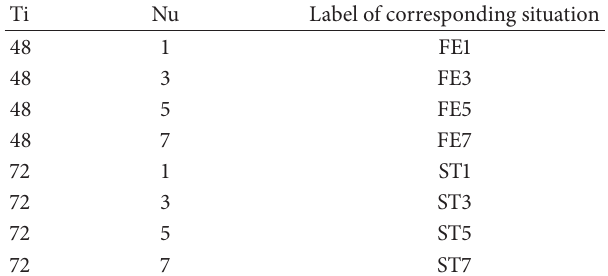
Table 3: 𝑃 , 𝑃 , and 𝑃 of each criterion. Table 4: The labels of different AJ FA FD